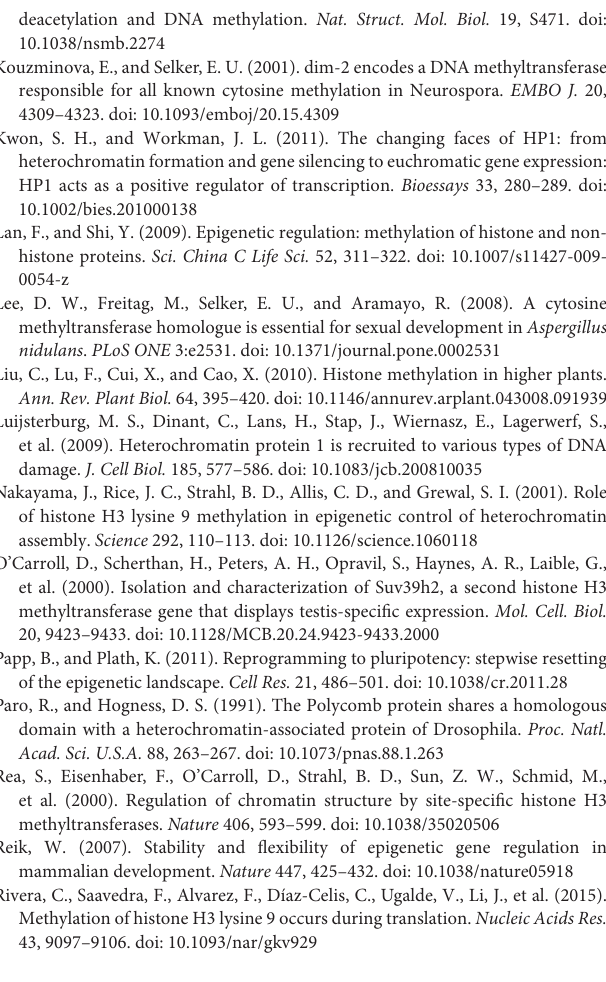
Figure S1 | Identification of BcDIM5 knockout and complemented transformants. (A) Principle of homologous recombination. (B) BcDIM5 knockout transformants identified by PCR. (C) BcDIM5 knockout transformants identified by RT-PCR. (D) BcDIM5 knockout transformants identified by Southern blot using HYG labeled with DIG as probe. (E) BcDIM5 complemented transformants identified by PCR. Figure S2 | Morphological comparison of the hyphal tips of BcDIM5 knockout and complemented transformants. Figure S3 | Virulence assay of BcDIM5 knockout and complemented transformants on detached soybean and tomato leaves. Virulence was evaluated based on the lesion diameter at 20 ◦ C for 48h. (A) Virulence assay of BcDIM5 knockout and complemented transformants on detached soybean leaves. (B) Virulence was evaluated based on the lesion diameter on soybean leaves. (C) Virulence assay of BcDIM5 knockout and complemented transformants on tomato leaves. (D) Virulence was evaluated based on the lesion diameter on tomato leaves. Figure S4 | Expression level of genes in different phase. Forty-eight hour indicates the wild type strain B05.10 grown in PDA for 48h, which is the hyphal growth stage; 156h indicates the wild-type strain B05.10 grown in PDA for 156h, which is the sclerotial development stage. IN indicates the wild-type strain B05.10 inoculated on A. thaliana leaves for 48h, which is the infection